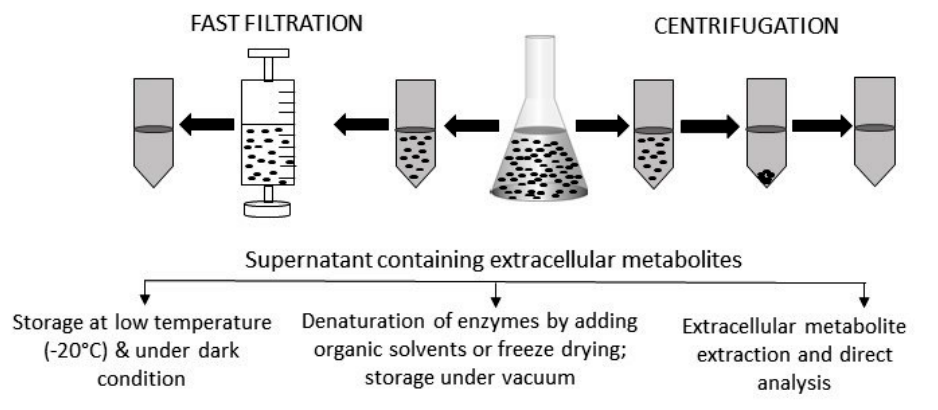
Figure 2. Extracellular sample preparation, handling, and storage. After centrifugation or fast filtration, culture media containing extracellular metabolites are usually stored at a low temperature and under dark conditions. Sometime, organic solvents are added to denature active enzymes. For some metabolites, specific extraction procedures need to be followed before being analyzed by appropriate instruments. Prior to analysis, extracellular samples are often freeze-dried to concentrate the level of metabolites.